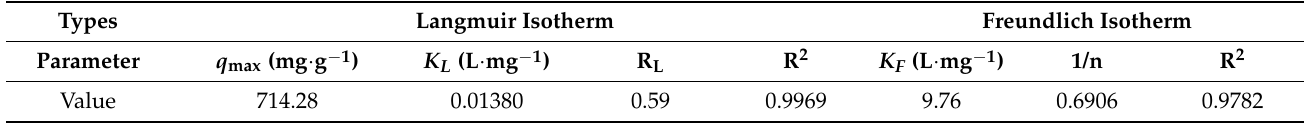
Table 6. Parameters of the Freundlich and Langmuir models for TA adsorption on steel slag.